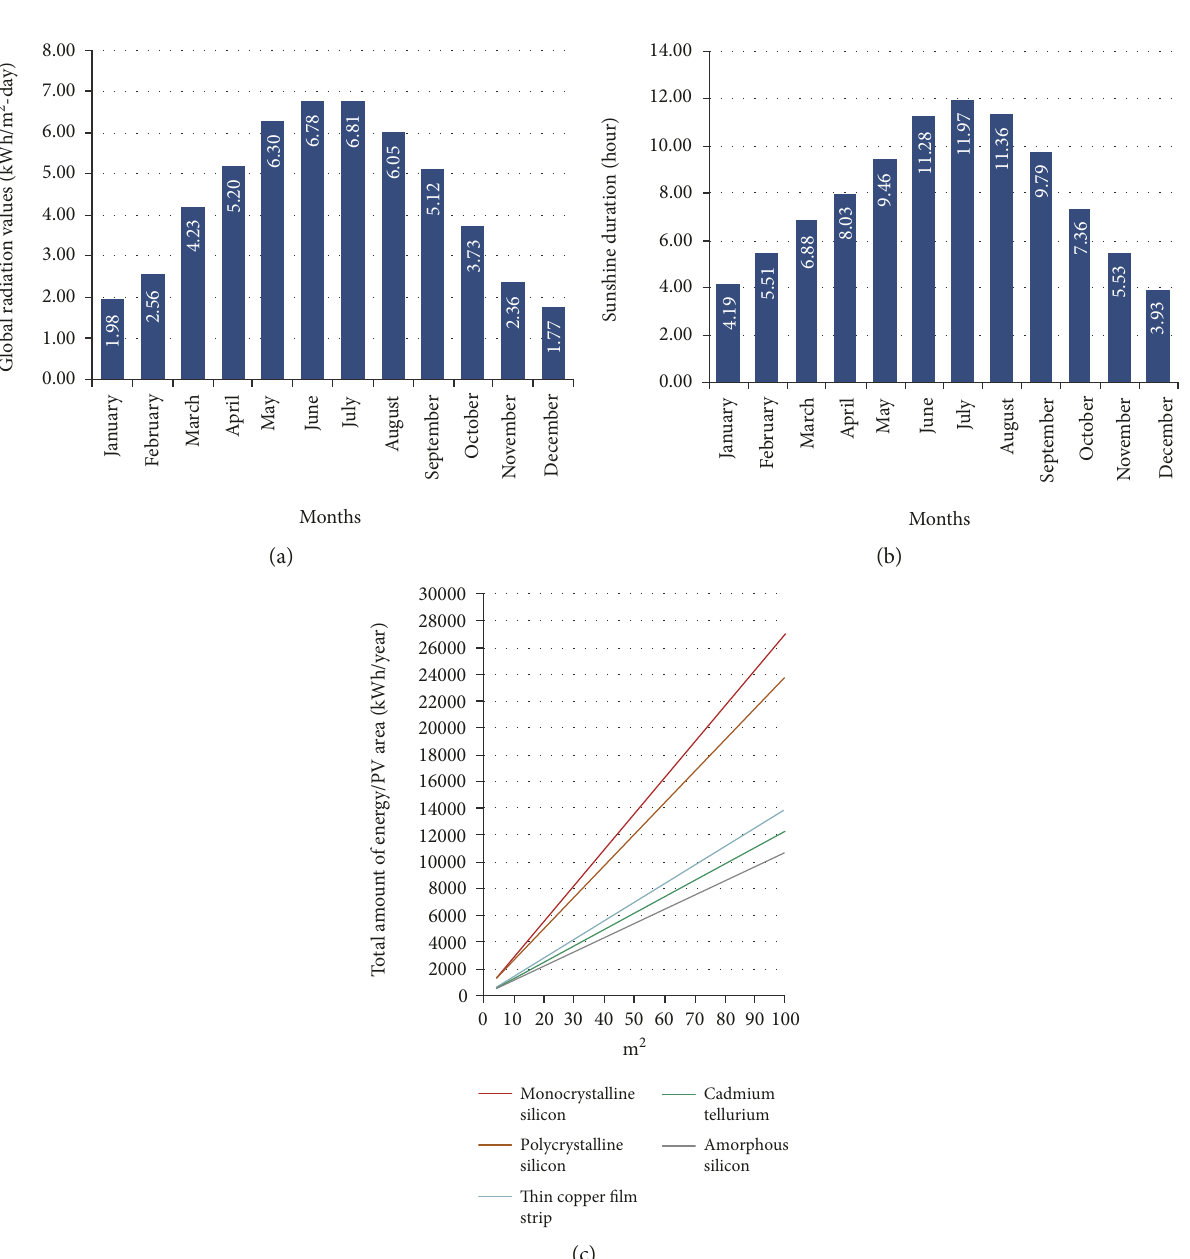
Figure 1: Konya province (a) global radiation values, (b) sunshine duration, and (c) total amount of energy/PV number of factors a ff ecting them is denoted by n . In the second step, comparison matrix among factors is formed.